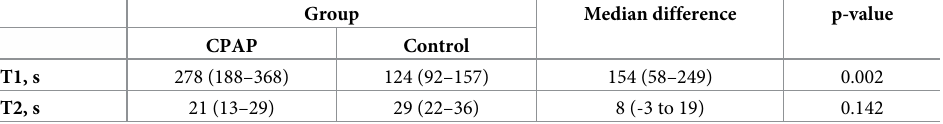
Table 2. T1 and T2 in children treated with CPAP ventilation and passive CPAP oxygenation (10 cmH 2 O) or no positive airway pressure (0 cmH 2 O) during anaesthesia induction for elective surgery. Group Median difference p-value CPAP Control T1, s 278 (188–368) T2, s 21 (13–29) 8 (-3 to 19) 0.142 T1, time between apnoea onset and an SpO 2 of 95% during a maximum observation time of 300 s; T2, time from an SpO 2 of 95% until recovery to pre-apnoea levels; SpO 2 , pulse oximetry oxygen saturation; CPAP, continuous positive airway pressure. Values are presented as median (95%